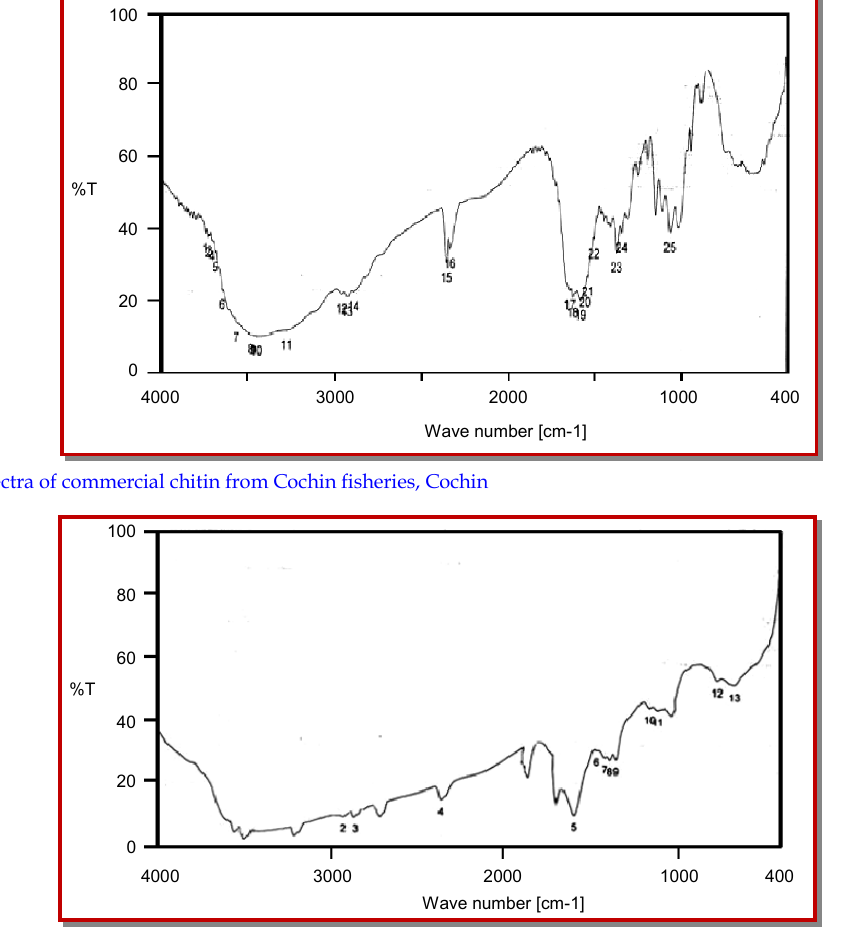
Figure 2: IR Spectra of isolated chitin from Rhizopus oryzae